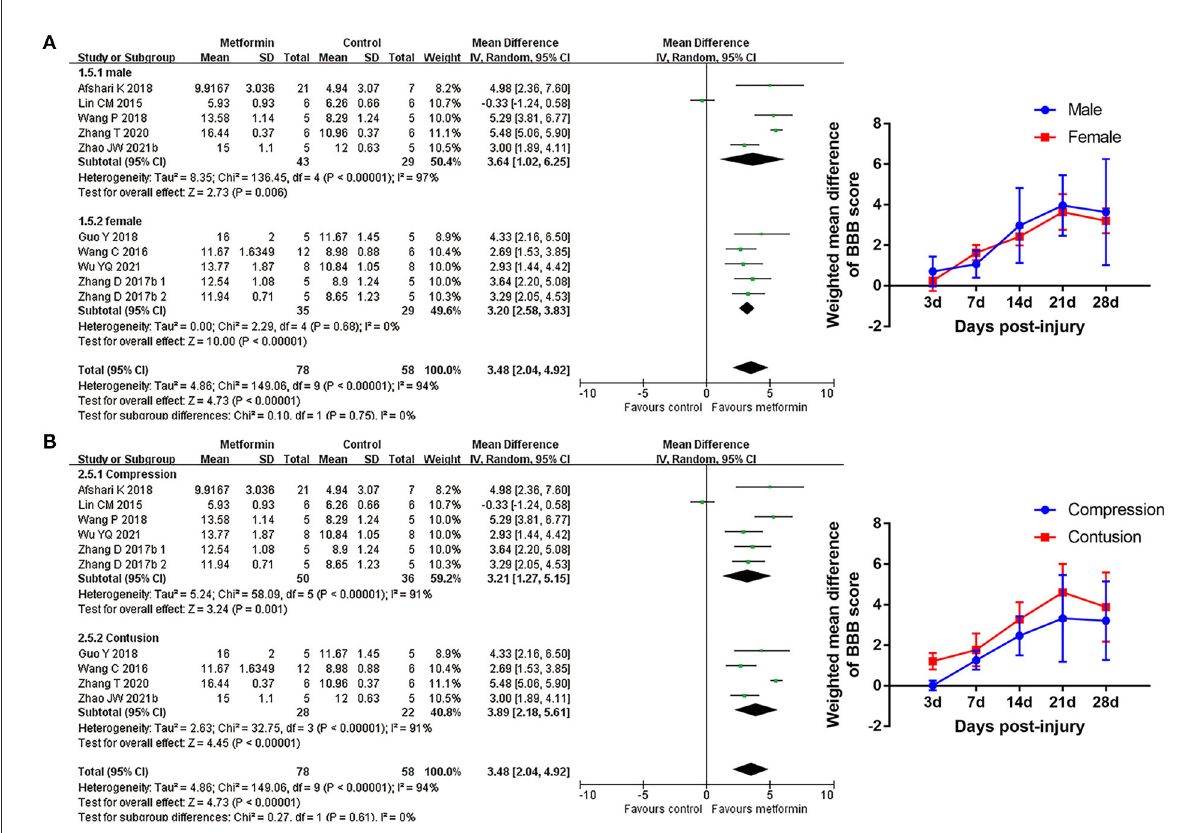
FIGURE4 BBB scale subgroup analysis concerning rat gender and injury model type. (A,B) Subgroup analysis concerning rat gender and injury model type at 28th day after SCI and the WMDs of BBB score over time in different subgroups.